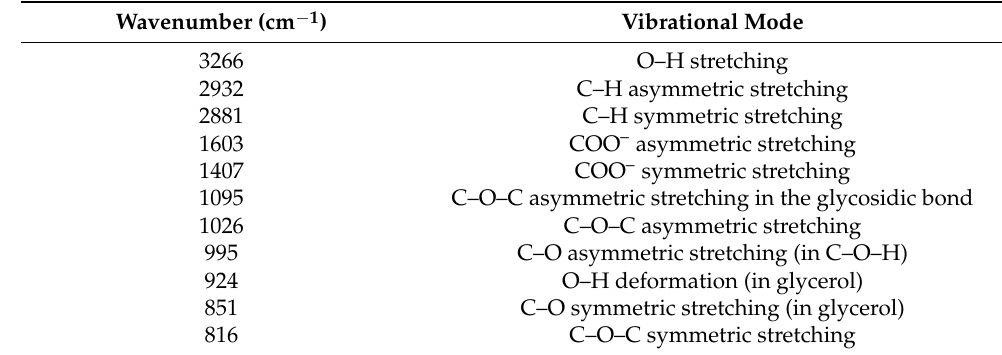
Table 2. The absorption band maxima and their assignment to the vibrational modes for sodium alginate film plasticized with glycerol